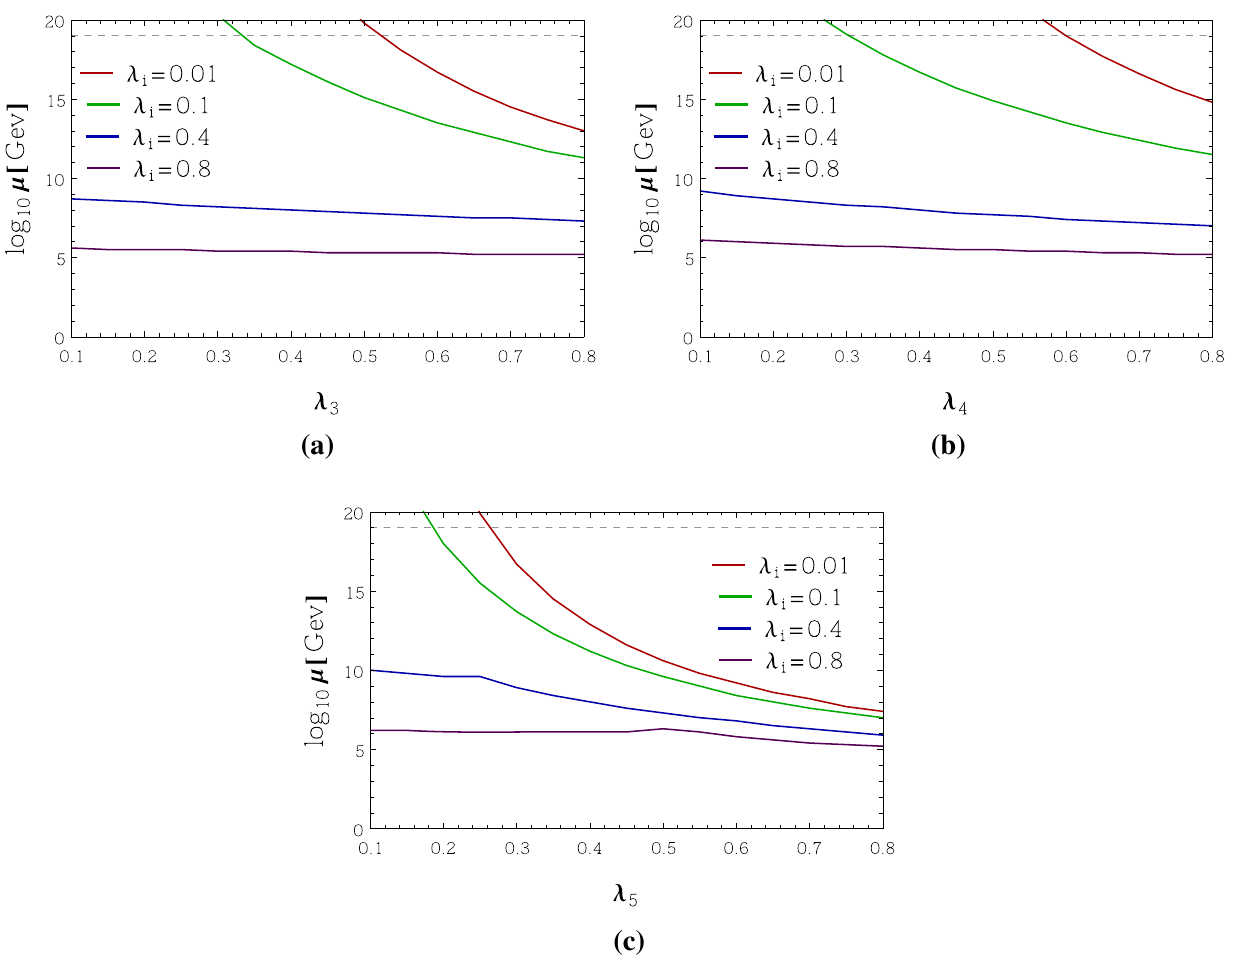
Fig. 4 Two-loop running of the scalar quartic couplings λ 3 , λ 4 and λ 5 as a function of perturbative scale. Here red, green, blue and purple curves in each plot correspond to different initial conditions for λ i (with